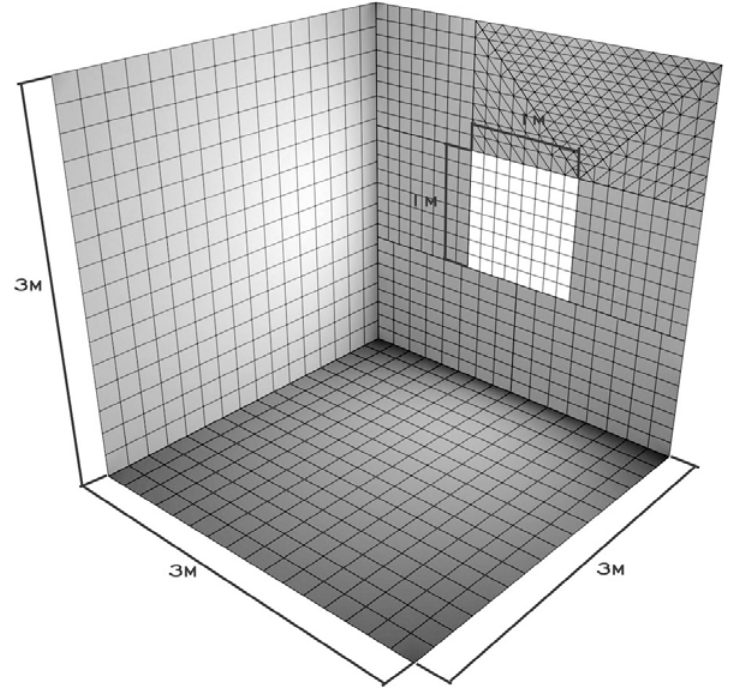
Figure 1. Trial model